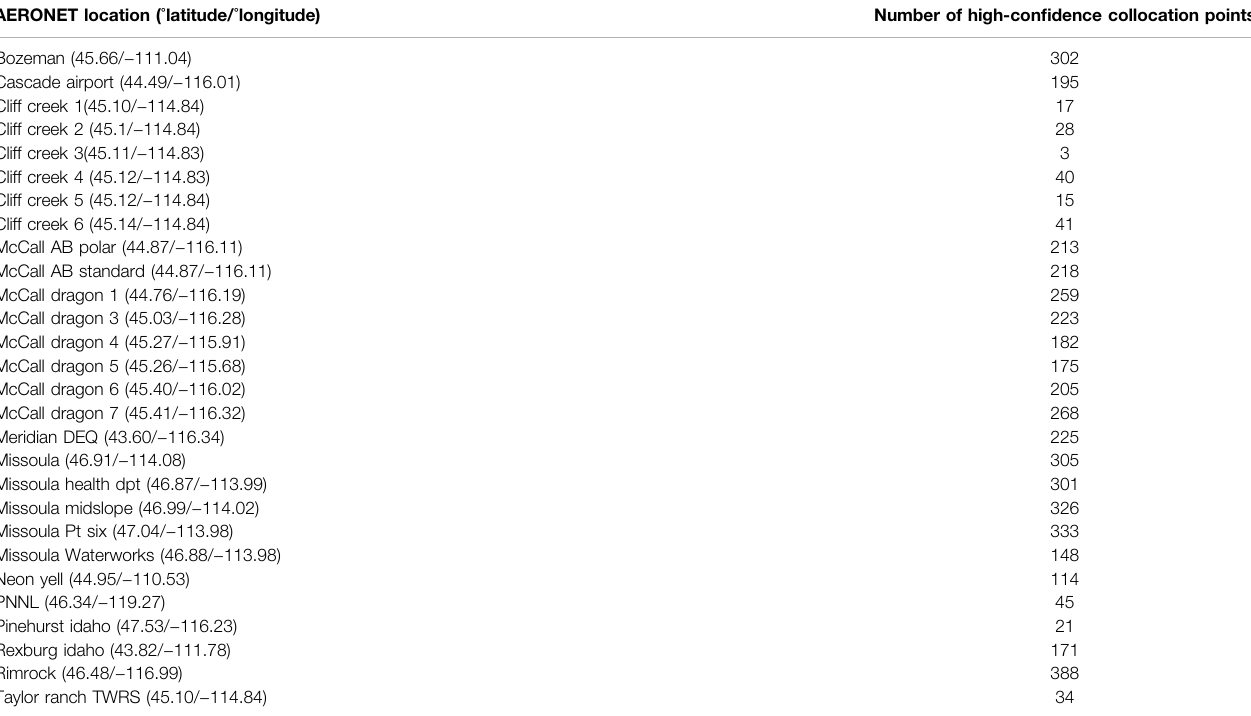
TABLE | AERONET locations within the FIREX-AQ domain collocated with high-con fi dence MAGARA observations and the resultant number of observations. AERONET location ( ° latitude/ ° longitude) Number of high-con fi dence collocation points Bozeman (45.66/ −